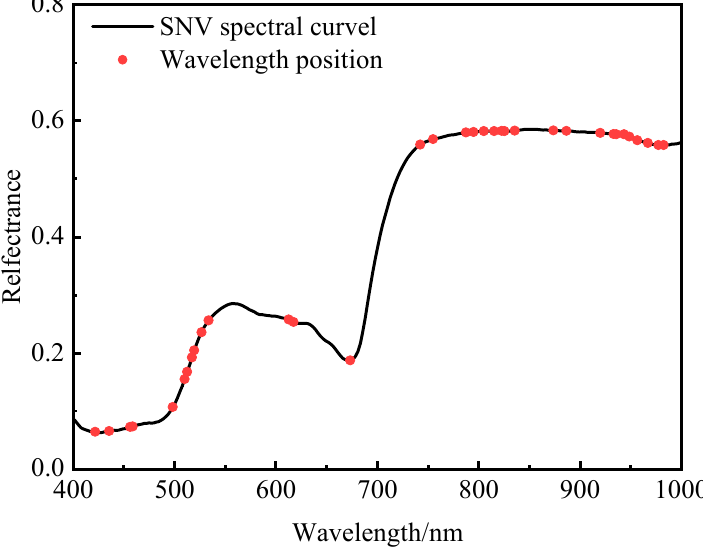
Figure 10. Characteristic wavelengths of the SNV spectral curve selected using the CARS algo- rithm.